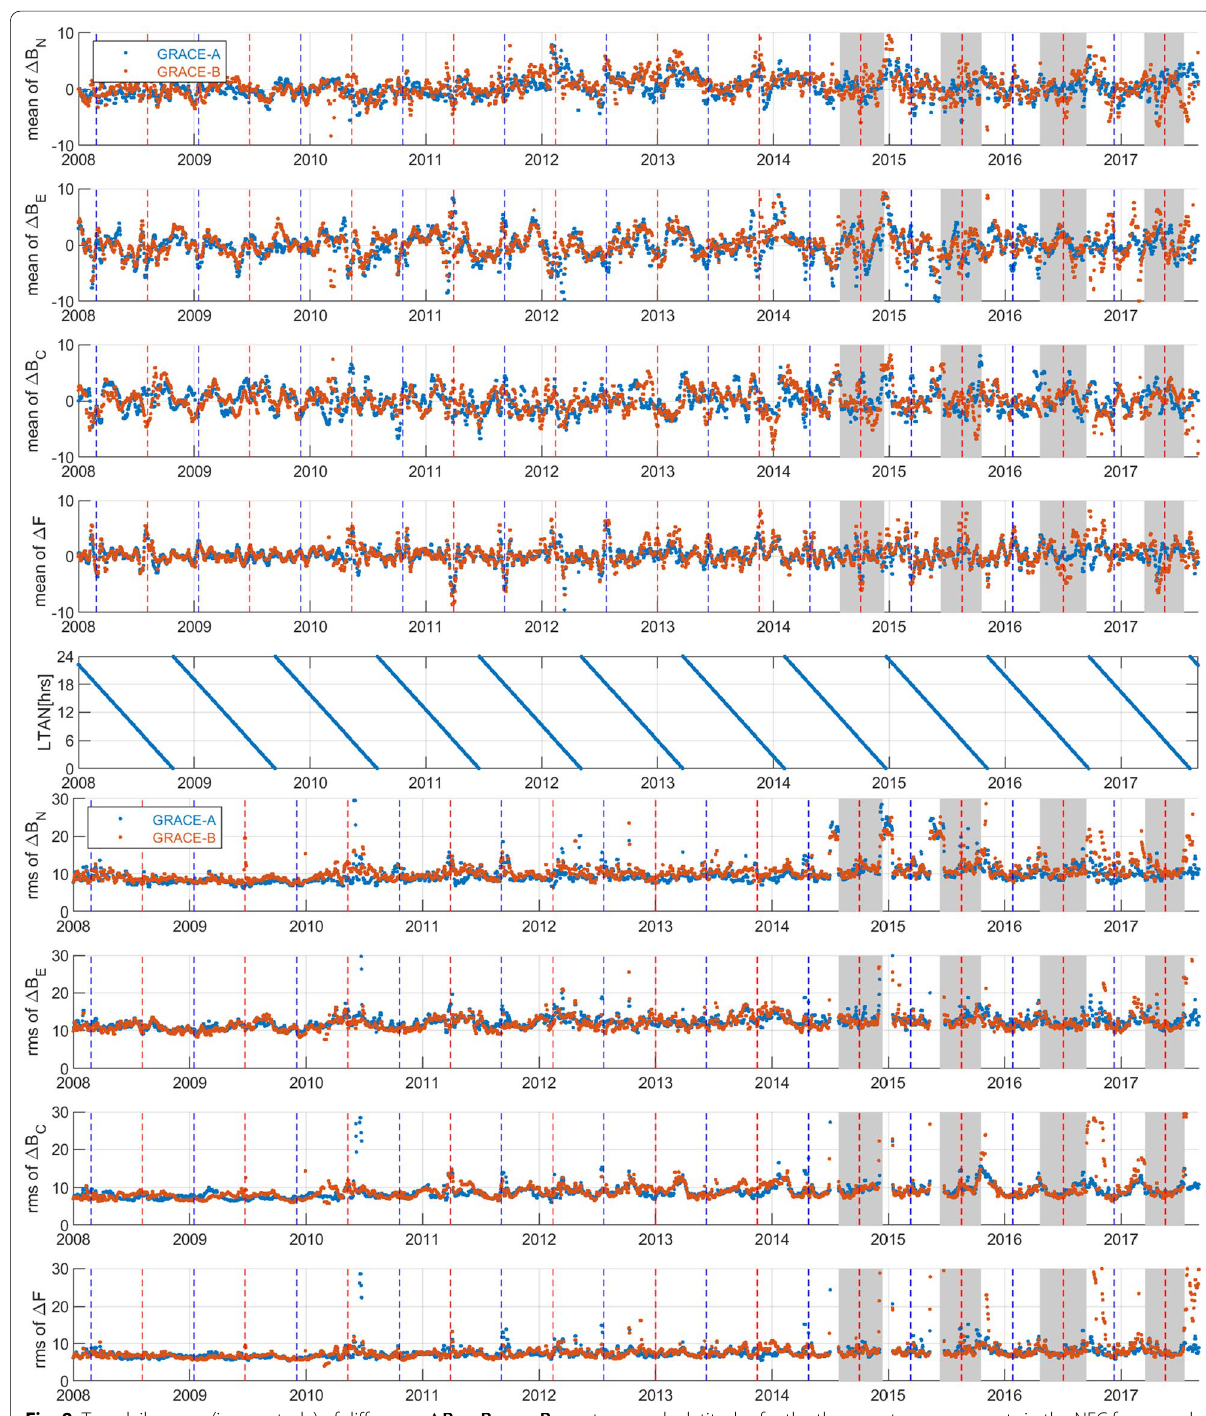
B B Fig. 8 Top: daily mean (in nanotesla) of difference (cid:31) B obs − mod at non-polar latitudes for the three vector components in the NEC frame and = F obs F mod . Vertical dashed lines indicate, respectively, 06 LT of the ascending node (red) and 18 LT (blue). Middle: Local for scalar intensity (cid:31) F = − Time of Ascending Node (LTAN). Bottom: daily rms (in nanotesla) of (cid:31) B and (cid:31) F ,